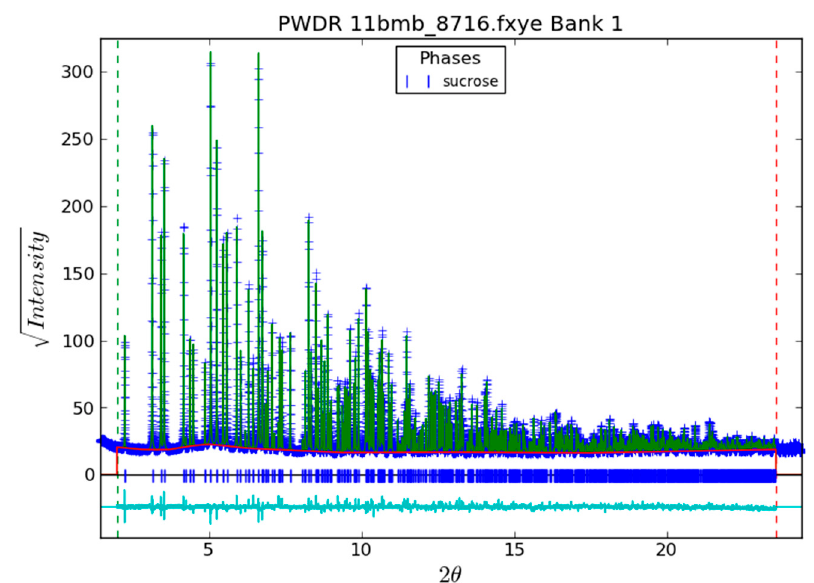
Figure 6. High resolution powder diffraction pattern of sucrose (C 12 H 22 O 11 , space group P2 1 , a = 7.7157 Å, b = 8.6643 Å, c = 10.8101 Å, β = 102.983°, Z = 2) in a 1 h scan at λ = 0.41326 Å taken at the Advanced Photon Source, beam line 11 BM. The portion of the data analyzed covers 2.0° ≤ 2 Θ ≤ 23.55° and comprises 21,554 profile points with a spacing of 0.001° 2 Θ . Observed data shown as blue (+), calculated pattern in green, background in red, difference shown below on same scale, and reflection positions indicated.